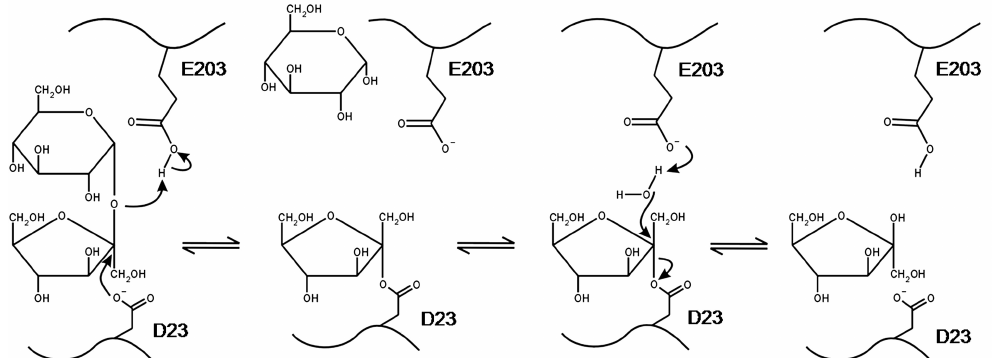
Figure 5. Reaction mechanism for INV enzymes. D23 and E203 are identified as nucleophile and acid/base catalysts, respectively. The figure is taken from reference [98]. Reprinted from the Journal of Molecular Biology , 377, Willem Lammens et al., Crystal Structures of Arabidopsis thaliana Cell-Wall Invertase Mutants in Complex with Sucrose, 378–385, Copyright (2008), with permission from